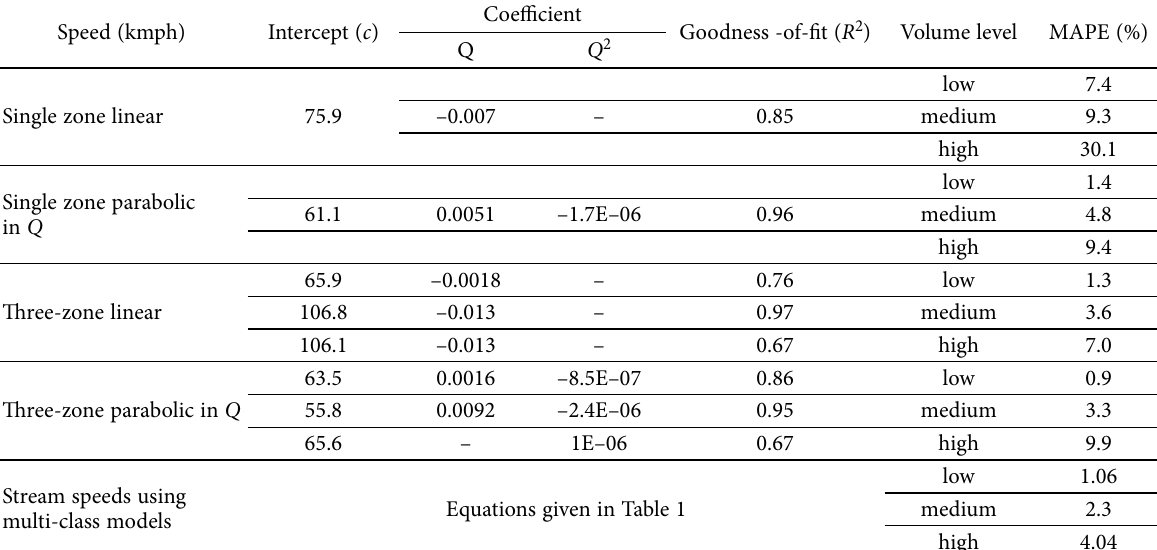
Table 2. MAPE % in stream speeds across different models